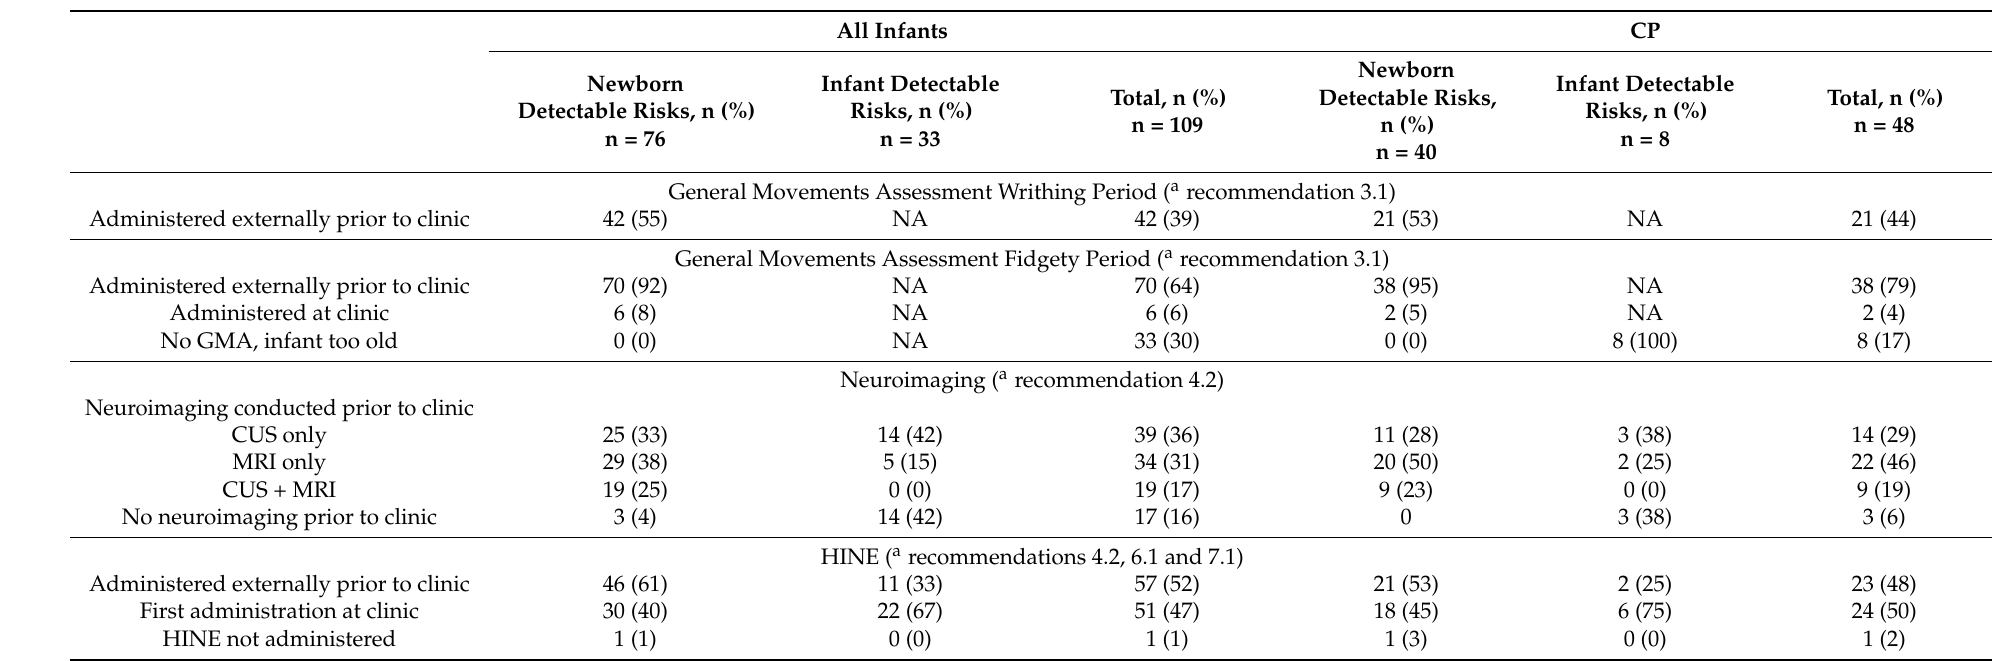
Table 5. Cerebral palsy-specific diagnostic tests completed a